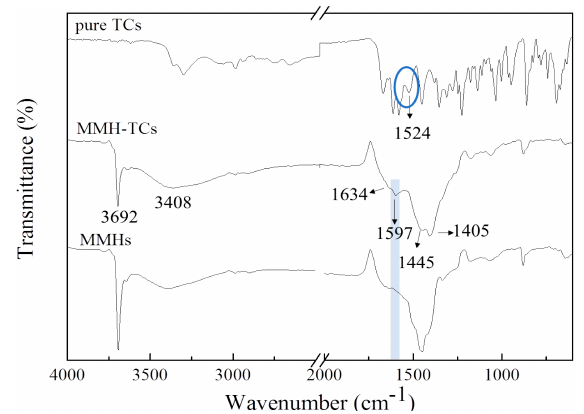
Figure 4. FT-IR spectra of pure TC, MMHs, and TC-MMHs.